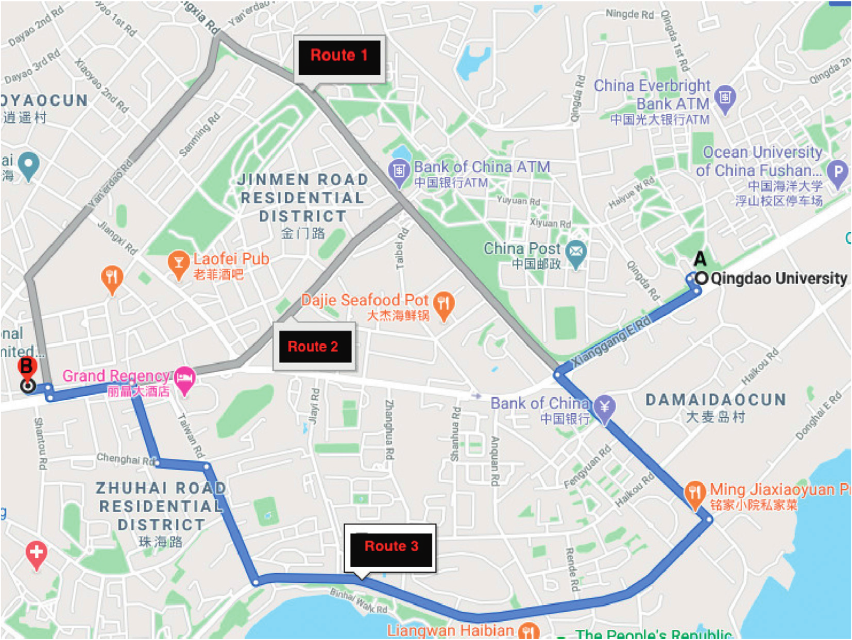
Figure 1: Routes in city of